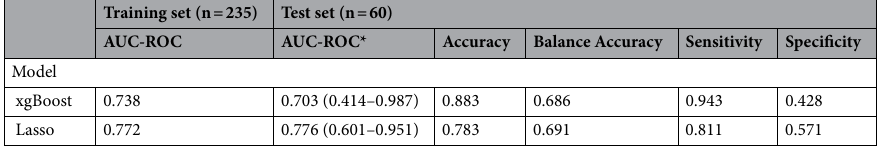
Table 1. Performance metrics of leptospirosis mortality models in the derivation and validation cohorts. *[95% Confidence Interval] based on 2000 bootstrap resamples.